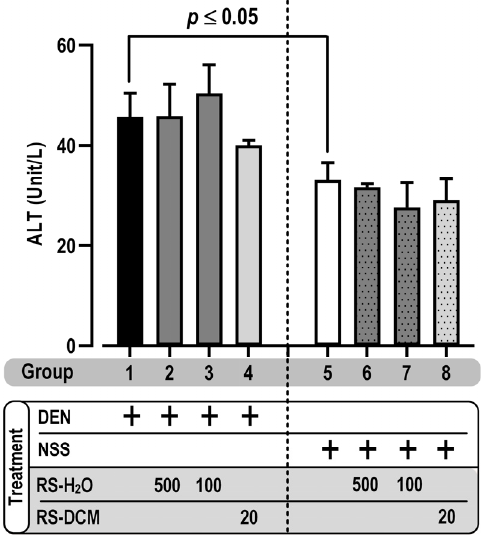
Figure 3. The e ff ect of RS on serum ALT level. The values are expressed as mean ± SD. The data were distributed normally (Shapiro–Wilk: p > 0.05) and were analyzed for statistical signi fi cance using one-way ANOVA with LSD’s post hoc test. RS dosage unit is mg/kg BW.